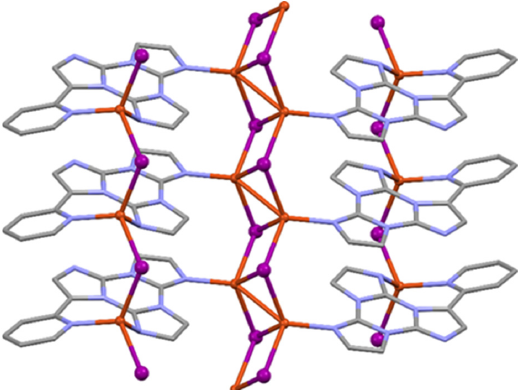
Figure 2. View of a single monodimensional chain of 1 , showing the central double-stranded stair and the two lateral single zig-zag structural motifs bridged by the ligand.